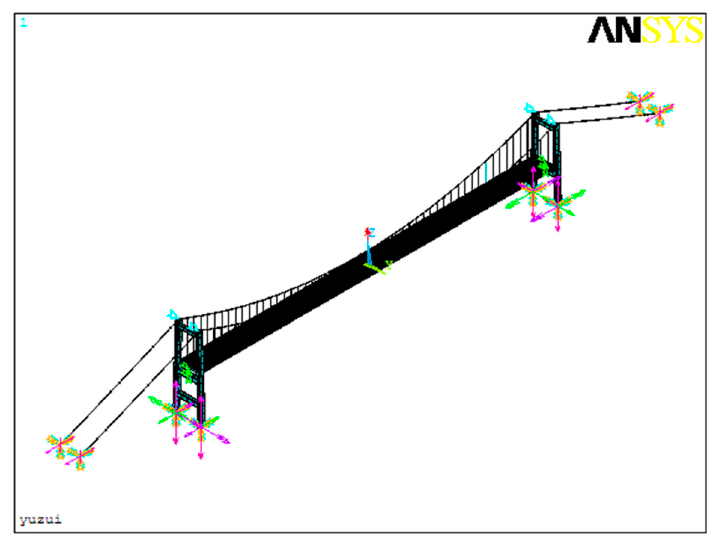
Figure 7. General arrangement of the bridge [35].